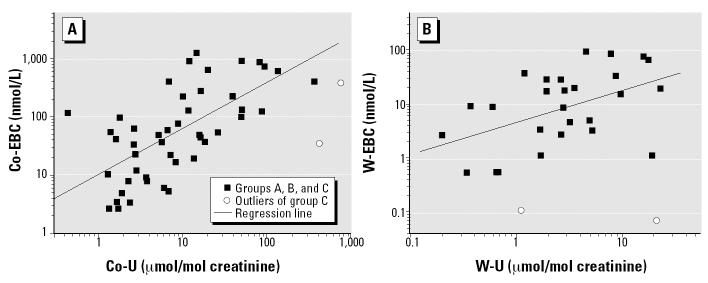
Correlation between (A) Co-U and Co-EBC levels and (B) between W-U and W-EBC levels. In (A), log(Co-EBC) = 0.99 + log(Co-U0.79); in (B), log(W-EBC) = 0.65 + log(W-U0.59).